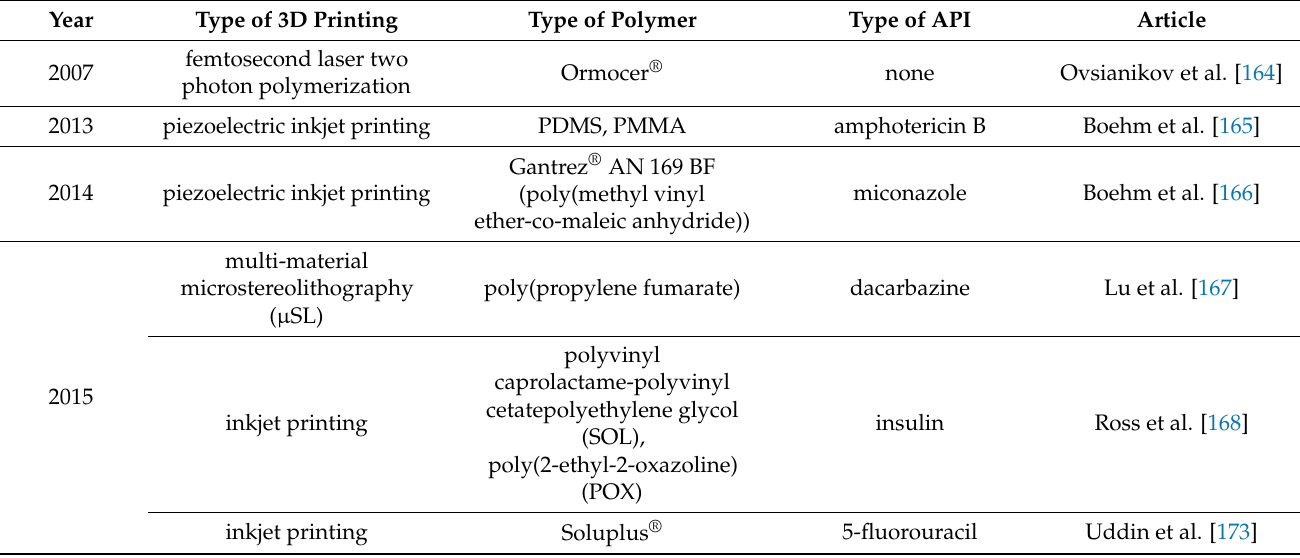
Table 7. The grouping of some manufactured microneedles based on the publication year and then in alphabetical